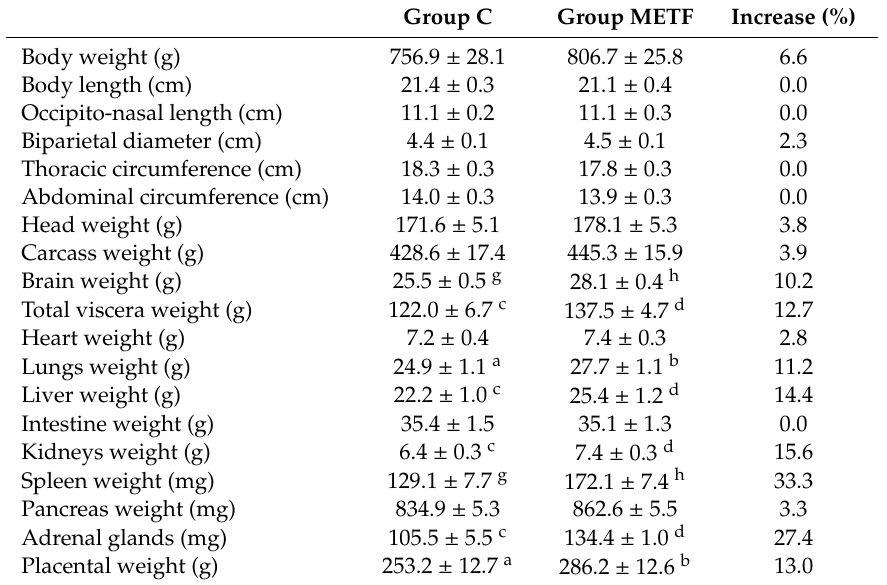
Table 2. Mean ( ± SEM) values for fetal size, total-body-weight, and weight of di ff erent organs and structures in control (group C) and metformin-treated fetuses (group METF) at day 100 of pregnancy. The third column represents the percentage of increase in the values when comparing group METF to group